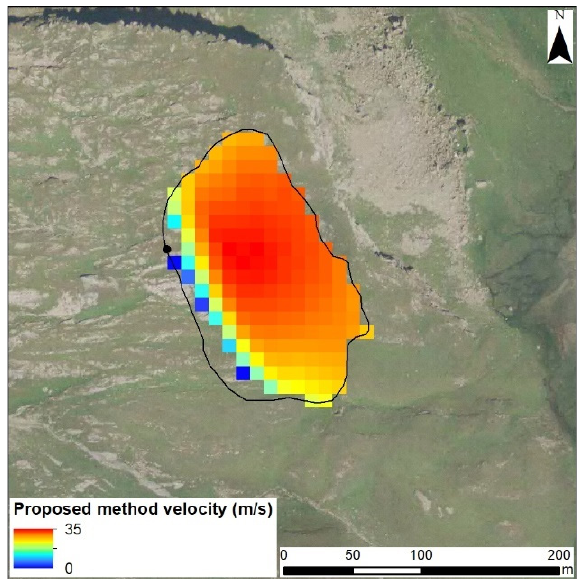
Figure 6. Velocity values of a rockfall obtained by a Matlab code based on the Heim method. The continuous black line corresponds to the landslide boundary, and the black point to the release reference point according to the IFFI inventory.